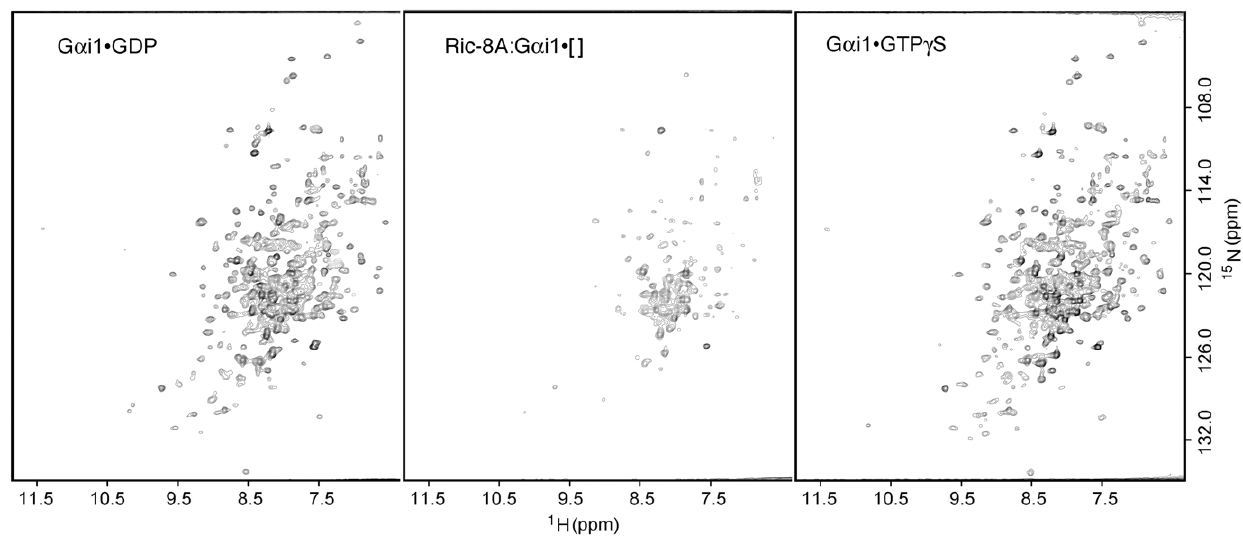
Figure 5. 1 H- 15 N TROSY-HSQC spectrum of G a i1 shows extensive peak broadening and intensity loss upon binding of Ric-8A. (A) 1 H- 15 N HSQC-TROSY spectra were acquired for [ 15 N]G a i1 N GDP, and (B) Ric8A:[ 15 N]G a i1[ ]. (C) After acquisition of the Ric-8A:[ 15 N]G a i1[ ] spectrum, a five molar excess of GTP c S was added to induce dissociation of Ric-8A and formation of G a i1 N GTP c S. After a short incubation, the free Ric-8A was removed by adsorption to IMAC resin, and the 1 H- 15 N TROSY-HSQC spectrum of the sample was recorded. Protein concentration, acquisition and processing parameters and contour levels in all panels are the same.